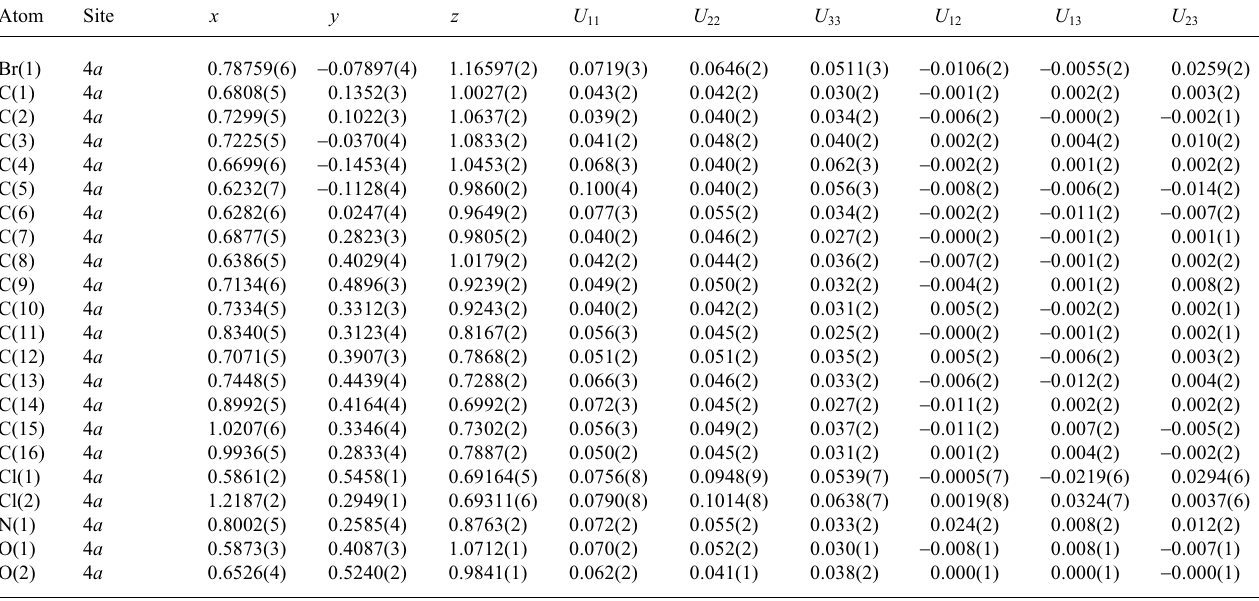
Table 3. Atomic coordinates and displacement parameters (in Å 2